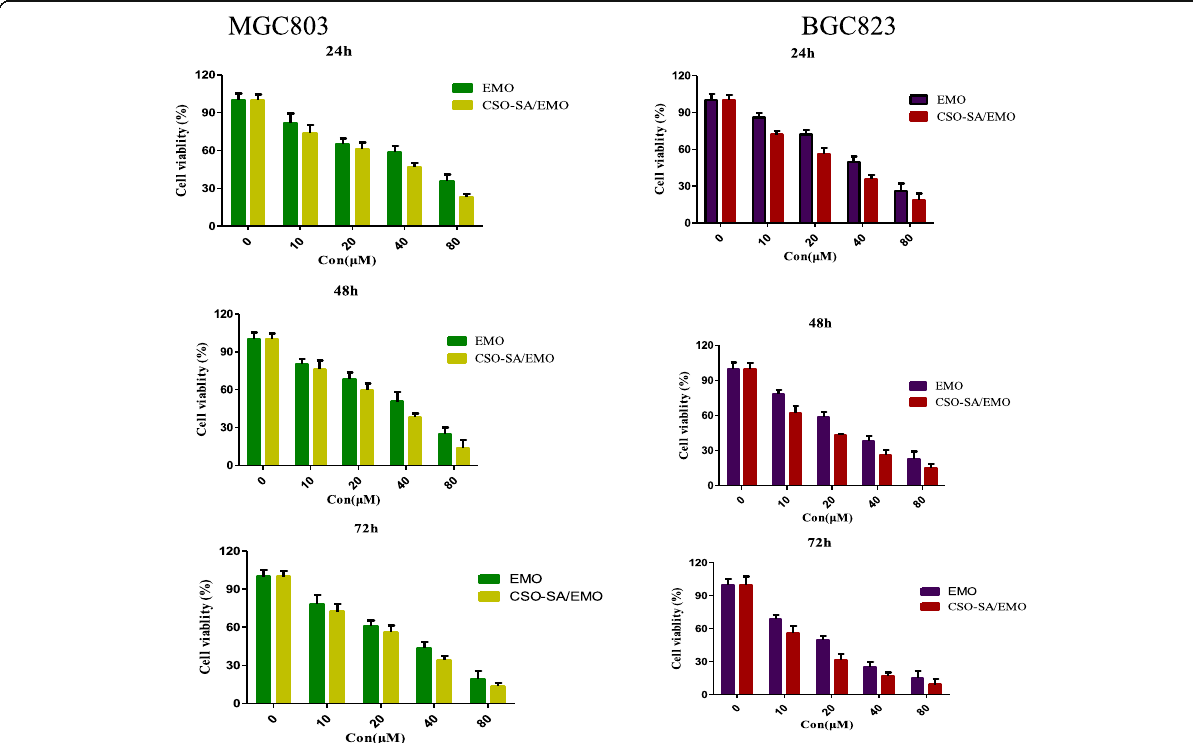
Fig. 7 Cell viability of MGC803 and BGC823 gastric cancer cells treated with CSO-SA, EMO, and CSO-SA/EMO for 24 h, 48 h, and 72 h. Data are presented as the means ± SD ( n =